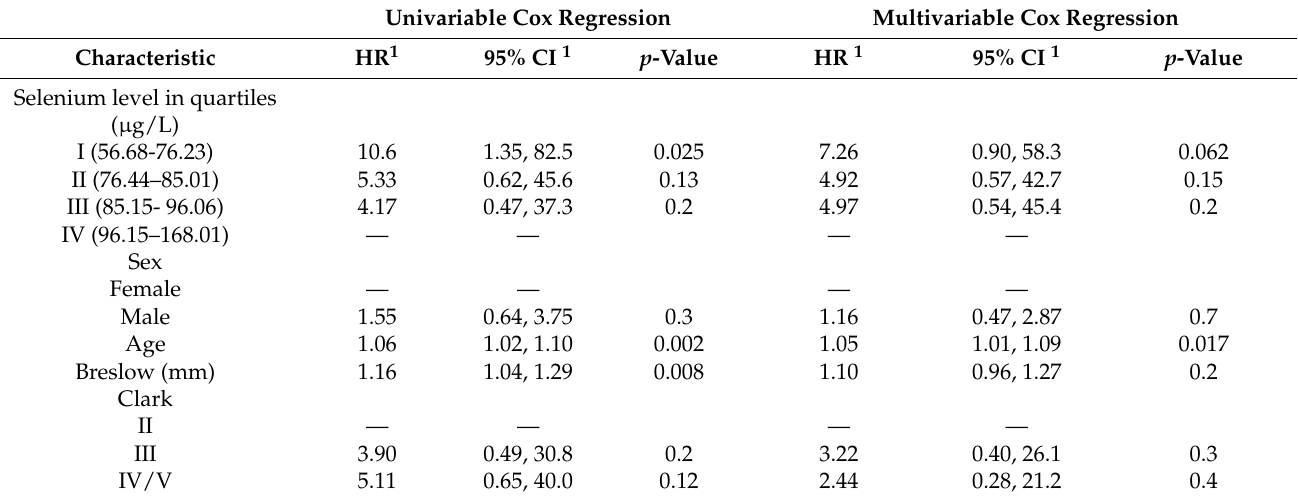
Table 4. Univariable and multivariable Cox proportional hazard models for given factors for 324 melanoma patients. Univariable Cox Regression Multivariable Cox Regression